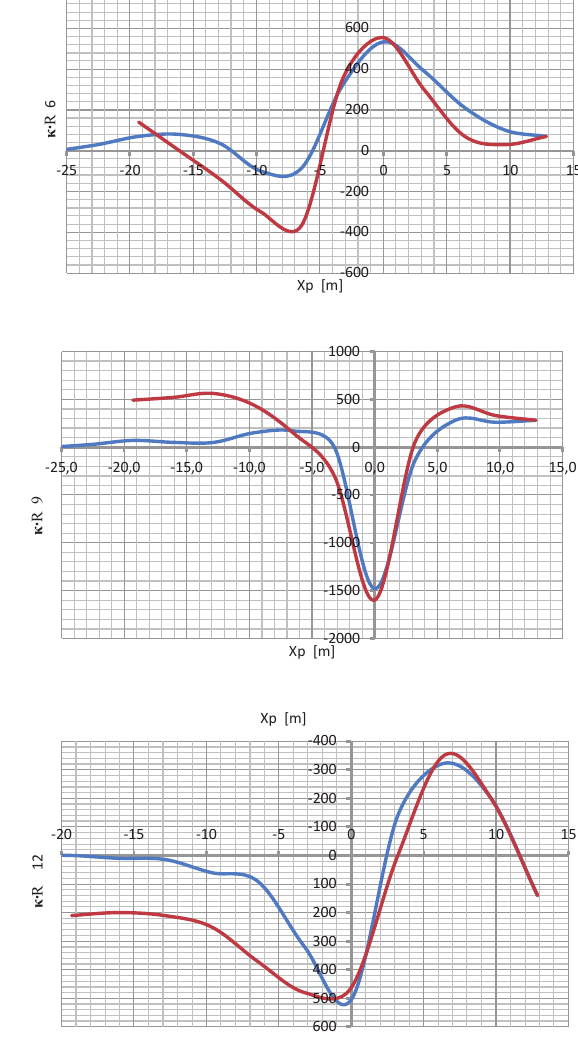
) for three points in the shell crown zone, Figure 7: Functions ρ( x p based on results presented in Figs. 5 and